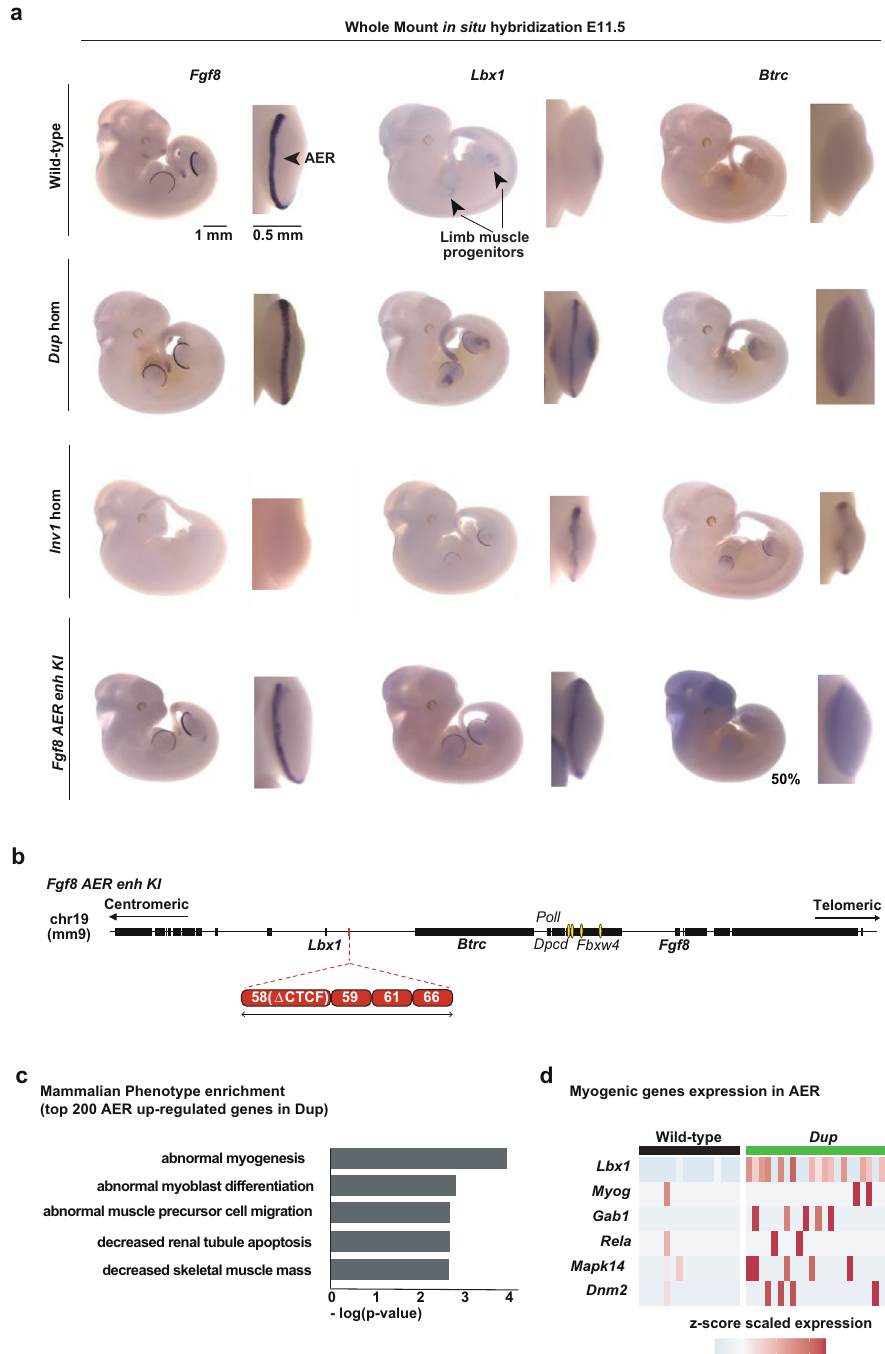
Fig. 5 | Ectopic interactions result in Lbx1 and Btrc misexpression in the AER. a Whole-mountinsituhybridizationfor Fgf8 , Lbx1 and Btrc atE11.5.Expressionwas checked and con fi rmed in at least 3 or more homozygous embryos (at least n =3 biologicalreplicates). b Schematicofthe Lbx1 / Fgf8 locusforCRISPR/Cas9 Fgf8AER enhancer KI allele. Yellowovals highlight Fgf8 AER enhancers. c GO analysisfor the MGI Mammalian phenotype enrichment terms 59 using the top 200 genes that are up-regulated genesinthe Dup mutant compared to wild-typein the AERcells from